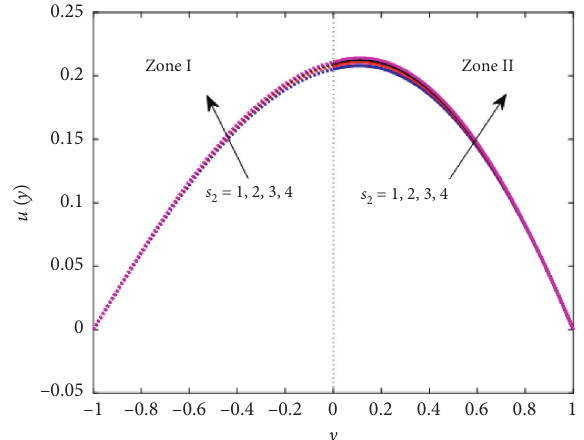
Figure 5: Velocity profiles for various s